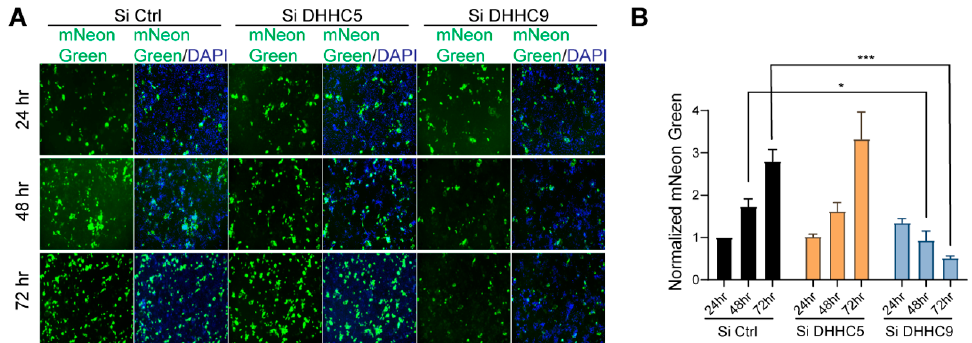
Figure 6. Effect of DHHC9 knockdown on SARS-CoV-2 infection in Caco-2 cells. ( A ) Caco-2 cells were knocked down for DHHC5 or DHHC9 and 48 h later, infected with icSARS-CoV-2-mNG (SARSCoV-2 stably encoding mNeonGreen; MOI 0.1). Then, 24, 48 and 72 h post-infection, the cells were fixed, nucleus stained with DAPI and visualized under a fluorescence microscope. ( B ) mNeonGreen signal from ( A ) was quantitated, normalized to DAPI and plotted to show the effect of the respective acyltransferase knocked down on icSARS-CoV-2-mNG infection. All data shown are averages of the results of at least three independent experiments (3 fields each) ± SD. * p < 0.05; *** p < 0.001 ( t -test).